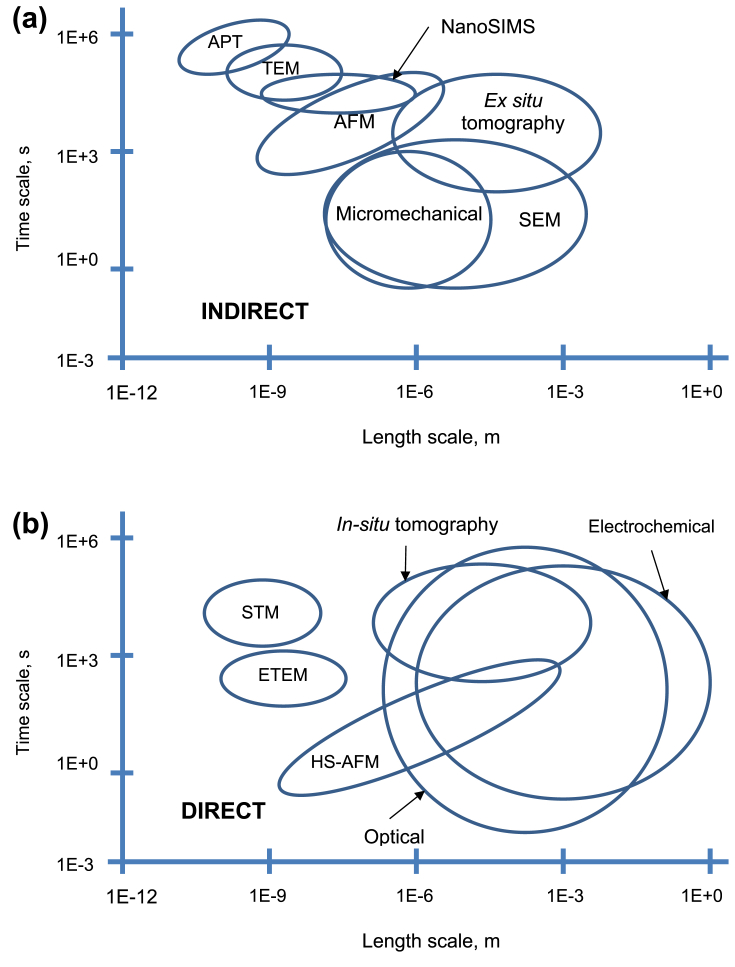
Schematic overview of selected techniques5 relevant to the study of SCC: (a) indirect; (b) direct.